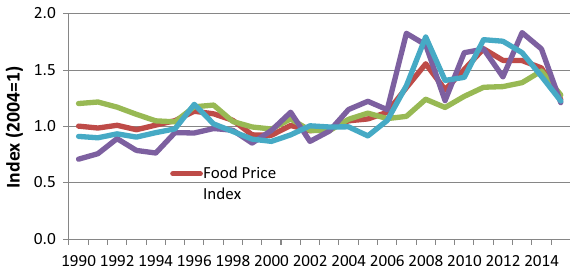
Fig. 2 Trends in World Food Price (Index, 2004 statistics